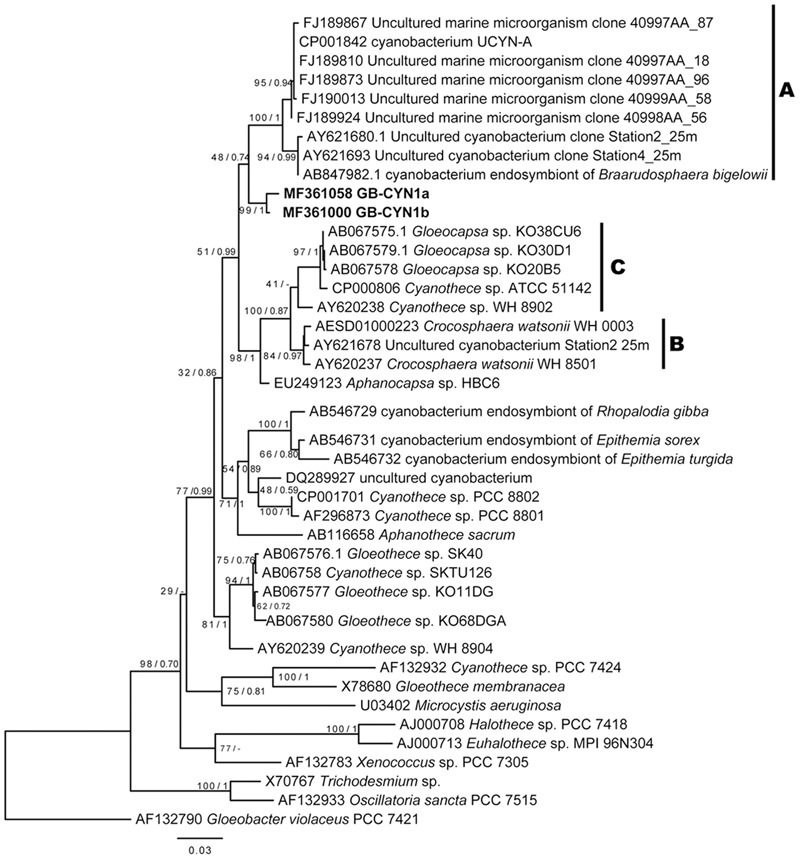
Maximum likelihood and Bayesian 16S rRNA gene phylogenies of GB-CYN1 species and related cyanobacteria. Reference sequences were full length and GB-CYN1 OTUs (bold) were partial (∼700–800 bp). Constructed from (A) 16S rRNA sequences from (partial sequences, ∼700–800 bp, bold) and Numbers at the nodes indicate bootstrap values from maximum likelihood analysis (1000 replicates) and the posterior probability of the Bayesian tree inference. The Bayesian consensus tree was concordant with maximum likelihood tree topology except where indicated by a dash. Scale bar represents the mean number of nucleotide substitutions per site. The major clades of unicellular cyanobacteria (UCYN-A-C) are labeled according to (Zehr et al., 2001; Langlois et al., 2005; Foster et al., 2007).